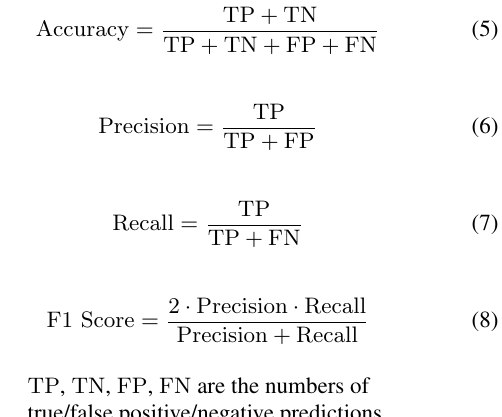
pixel crops but evaluate the entire images by drawing 4 non- from the original data, resulting in 3,944